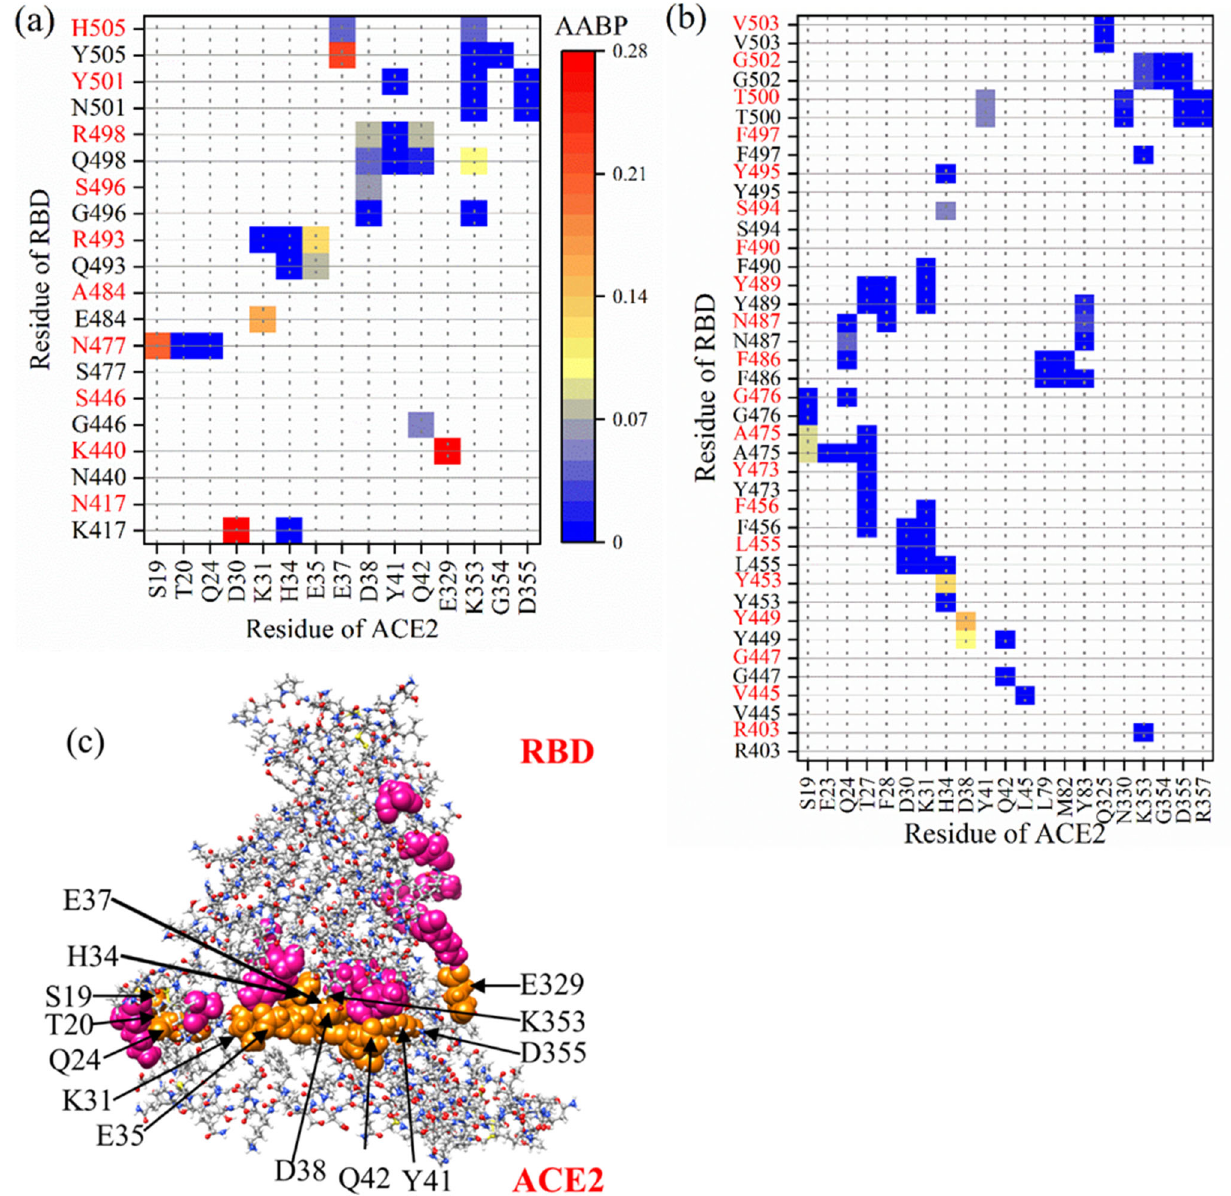
Figure 8. AABP map showing interaction of ( a ) mutated and ( b ) unmutated AAs of RBD with ACE2 in the interface model. WT and OV AAs are listed in y -axis labels in black and red color respectively. ( c ) Ball stick figure of mutated RBD-ACE2 model showing interaction between ACE2 AAs (orange sphere) with mutated AAs of RBD (pink sphere). Grey: C, red: O, blue: N, and white: H.